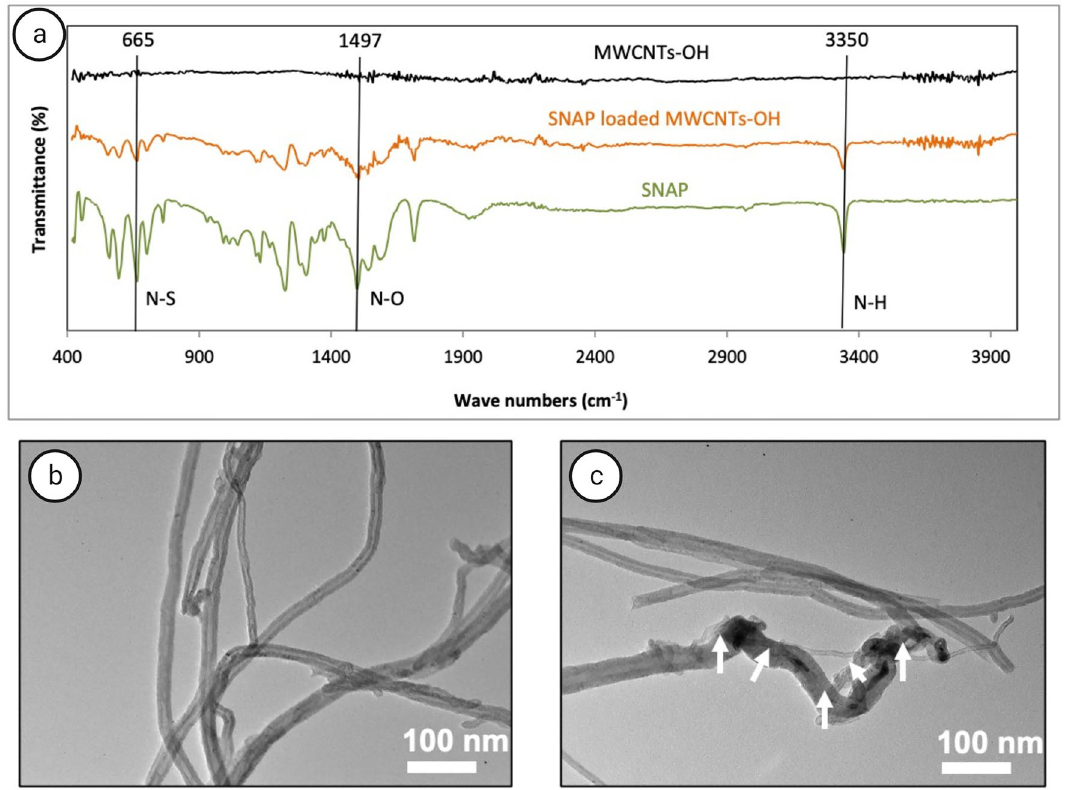
Figure 3. Characterization of ~ 5 w/w % SNAP loaded in MWCNTs. ( a ) FTIR spectra of SNAP, SNAP loaded MWCNTs-OH and MWCNTs-OH. TEM inspection of ( b ) MWCNTs and ( c ) SNAP loaded MWCNTs. White arrows indicate loaded SNAP. Scale bars: 100